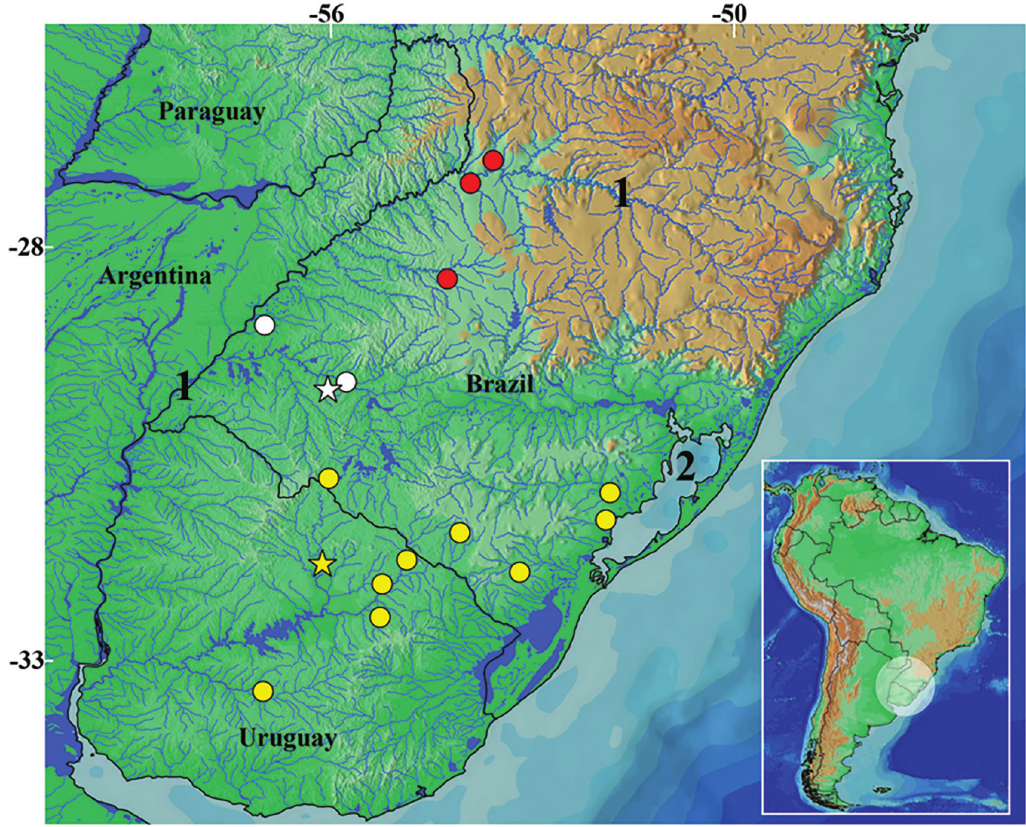
Fig 5. Geographic distribution of Ituglanis inusitatus , new species (white symbols), I. australis (yellow symbols) and Ituglanis sp. 3 (red symbols). Some symbols represent more than one collection locality. Stars represent type localities. Numbers 1 and 2 indicate rio Uruguay and laguna dos Patos,